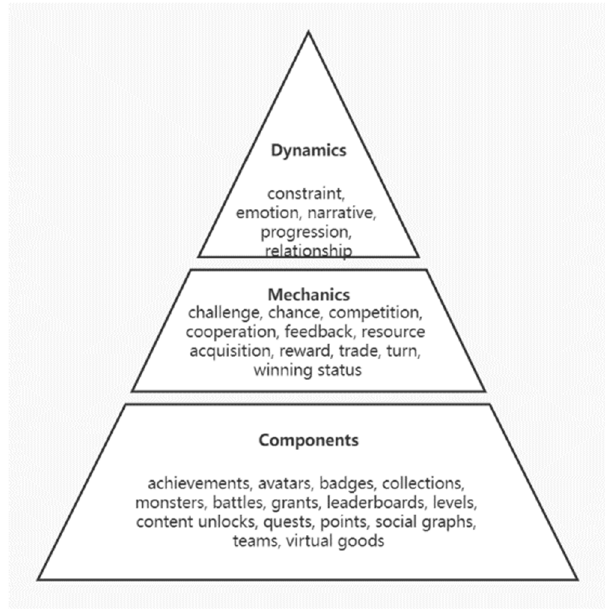
Figure 1. DMC pyramid model.